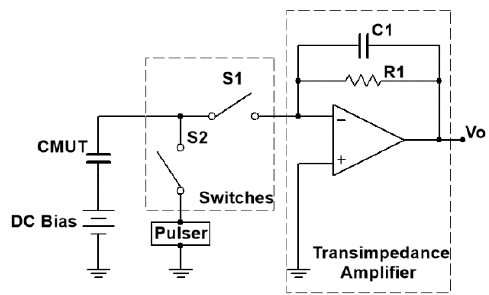
Figure 1. Circuit structure of the integrated front-end circuit.